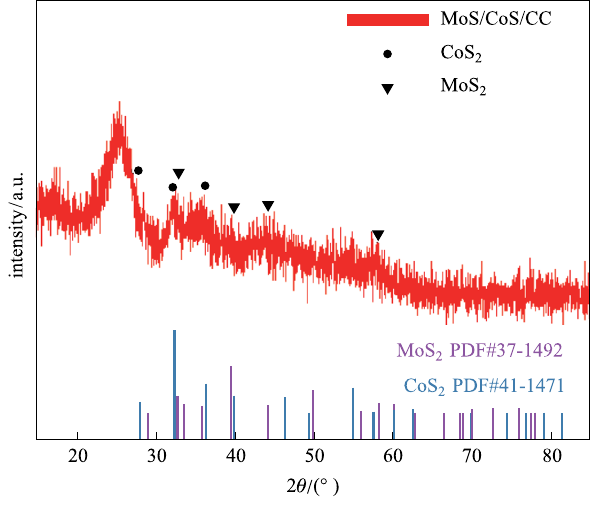
XRD patterns of MoS/CoS/CC electrocatalysts